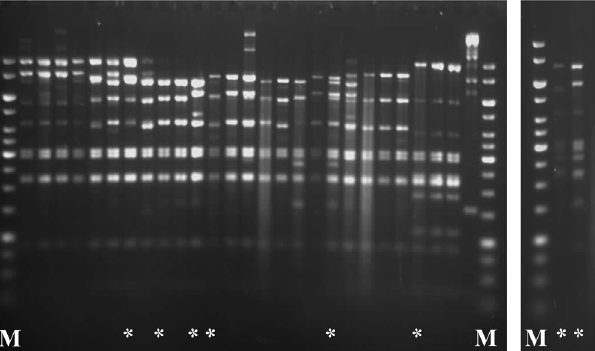
Figure 1. Restriction enzyme profiles of representative Lactococcus phages analysed in this study. DNA samples were cut overnight with EcoRV at 37 °C and treated with 50% formamide to dissociate cos ends prior to electrophoresis. M: 1-kb DNA Ladder (Fermentas). Unique phage DNA restriction patterns are marked by an asterisk ( *